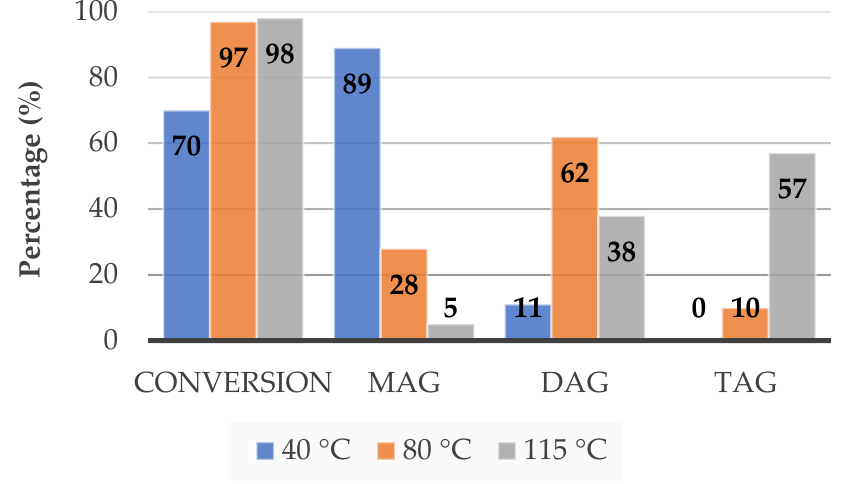
Figure 4. Effect of temperature on conversion and selectivity for the 1:9 G:AA molar ratio conditions. In the work of Nda-Umar [48], a different behavior in glycerol esterification values was observed upon reutilization of mesoporous sulfonated carbons (OMSC) catalyst derived from palm kernel shell biomass (PKS). Glycerol conversion remained almost constant throughout five catalytic cycles ( ≈ 98%). A significant decrease in TAG selectivity was observed, decreasing from 66.5% in the first run to 22.2% in the fifth cycle. Since this is a consecutive reaction, this decrease is relational to an increase in DAG and MAG selectivity, optimized the temperature (126 ◦ C), G:AA molar ratio (1:10.4), catalyst load (0.45 g), and